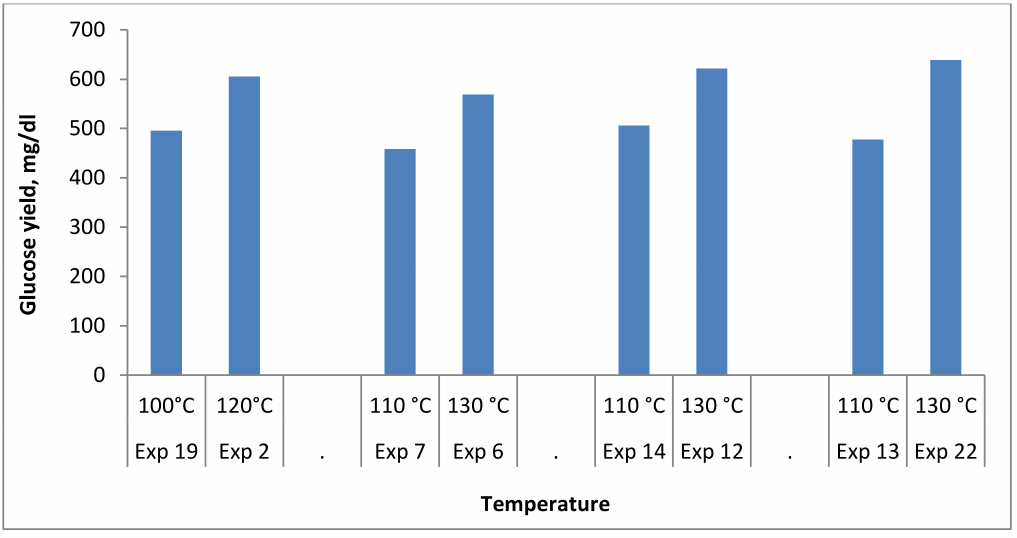
Figure 7. Effect of temperature on the glucose production